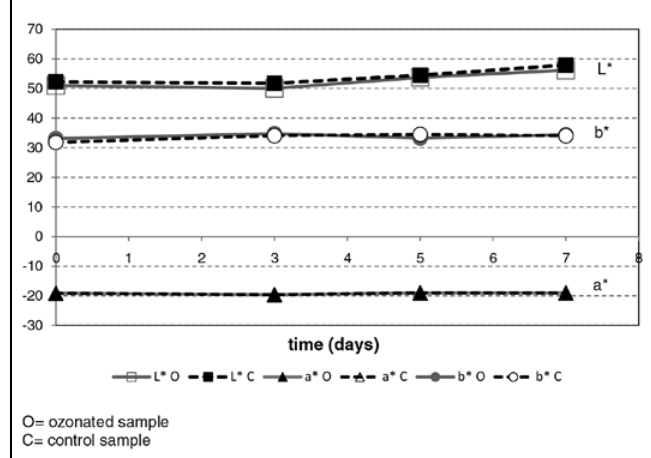
Fig. 5 - L*, a* and b* values determined on the upper leaf